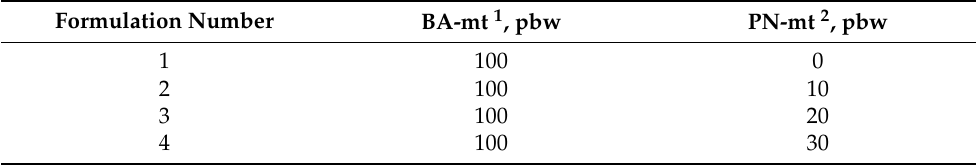
Table 1. Formulation of mixtures in parts by weight